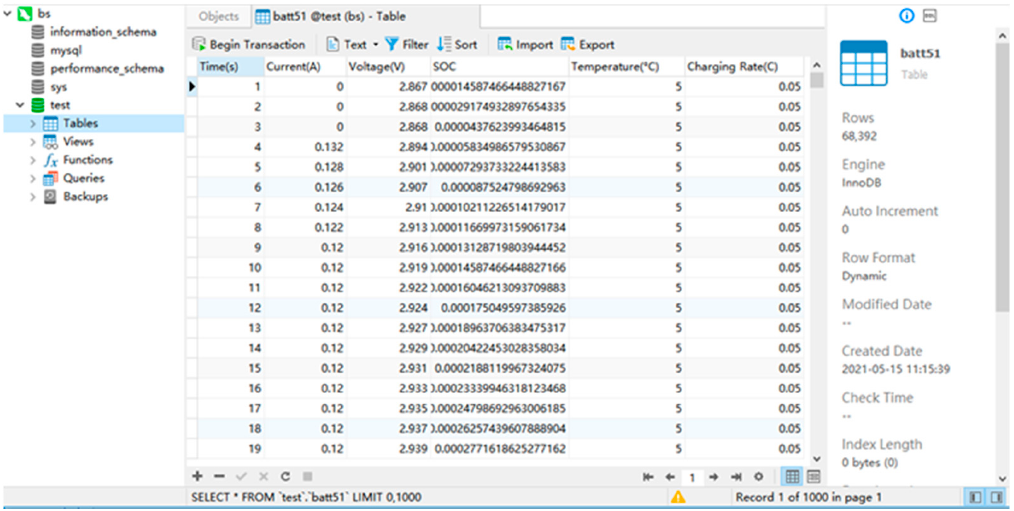
Figure 6. Example of written data table.